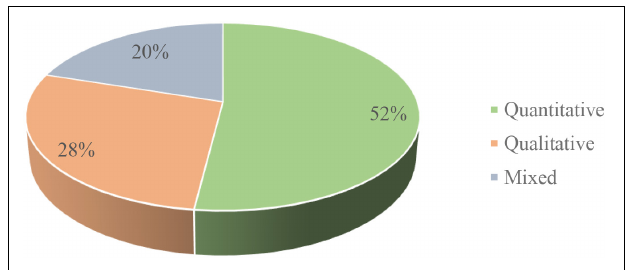
FIGURE 3 | Distribution of articles by research